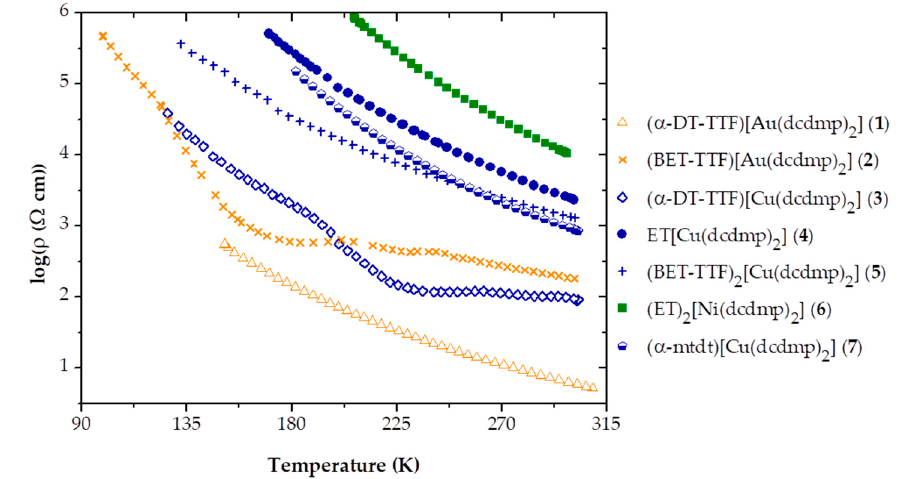
Figure 9. Electrical resistivity ρ of compounds 1 – 7 as a function of temperature T . Table 1. Room-temperature electrical conductivity ( σ RT ) and activation energy (E a ) of compounds 1 – 7 . CT